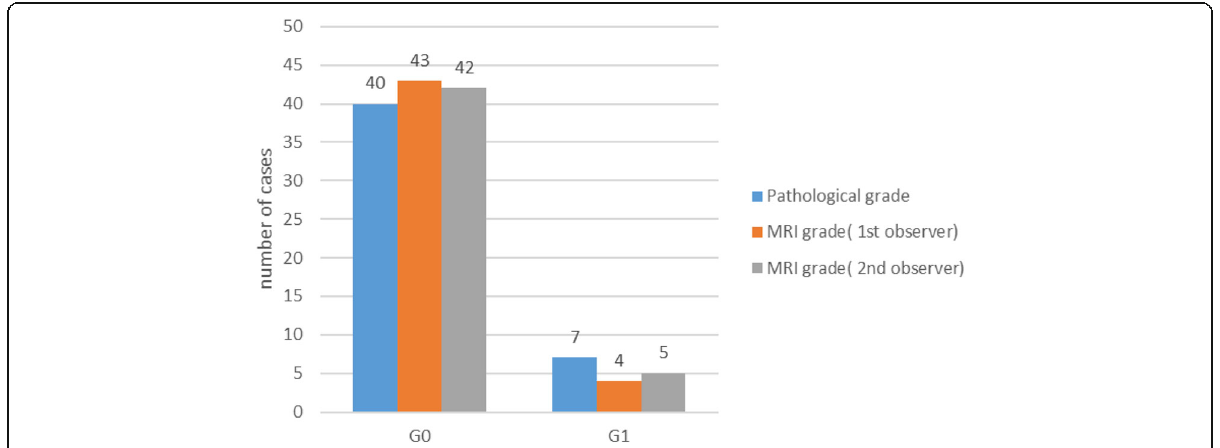
Fig. 3 Bar chart for frequency of MR hepatic fat fraction grades versus histopathological grades of hepatic